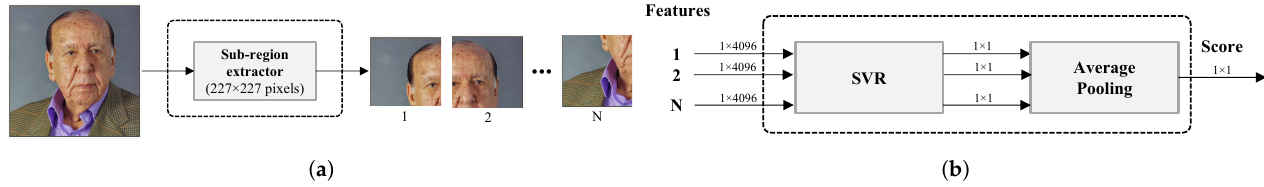
Figure 4. The main components of the DeepBIQ model. ( a ) The sub-region extractor, which divides an image of variable resolution into a grid of overlapping sub-regions of size 227 × 227 pixels. ( b ) The feature vectors extracted from the CNN for each sub-region are fed into the SVR, which predicts a quality score for each of them. The quality score for the entire image is calculated by average pooling the predicted scores on all the sub-regions of the original image.